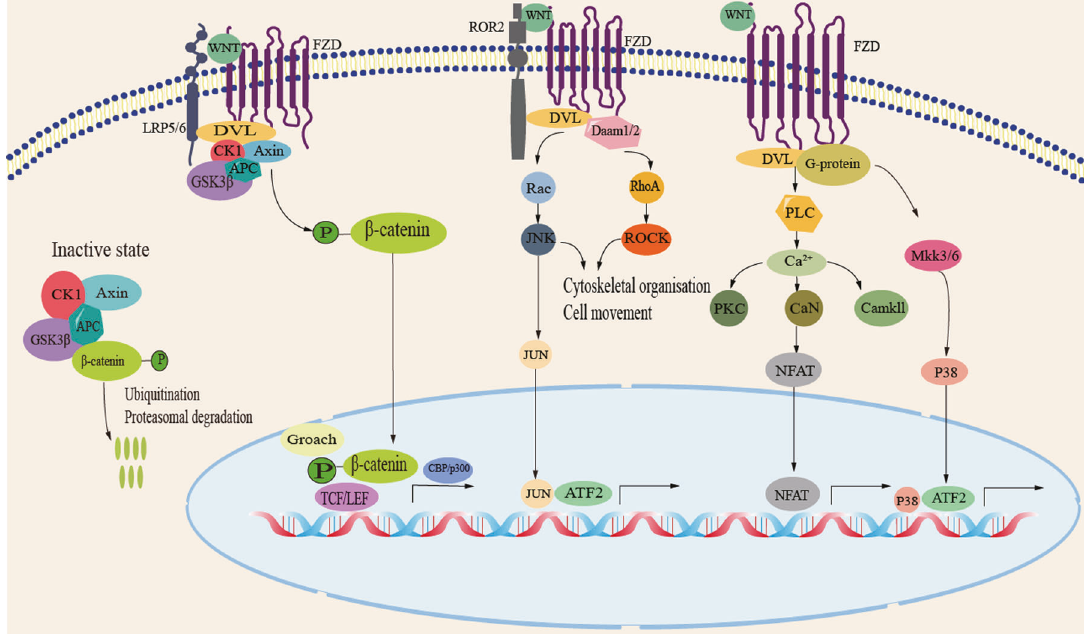
Fig. 2 WNT4 signaling pathway. WNT4 regulates at least three distinct intracellular signaling pathways: β -catenin, planar cell polarity (PCP)/ JNK, and Ca 2 + /CaMK pathways. In canonical WNT pathway, extracellular WNT ligand binds to FZD and LRP5/6 on the cell membrane and recruits DVL protein to promote dissociation of the β -catenin destruction complex, followed by accumulation of β -catenin, which translocates to the nucleus to interact with target downstream signaling molecules and activate intracellular signaling cascades. In WNT/PCP/JNK pathway,